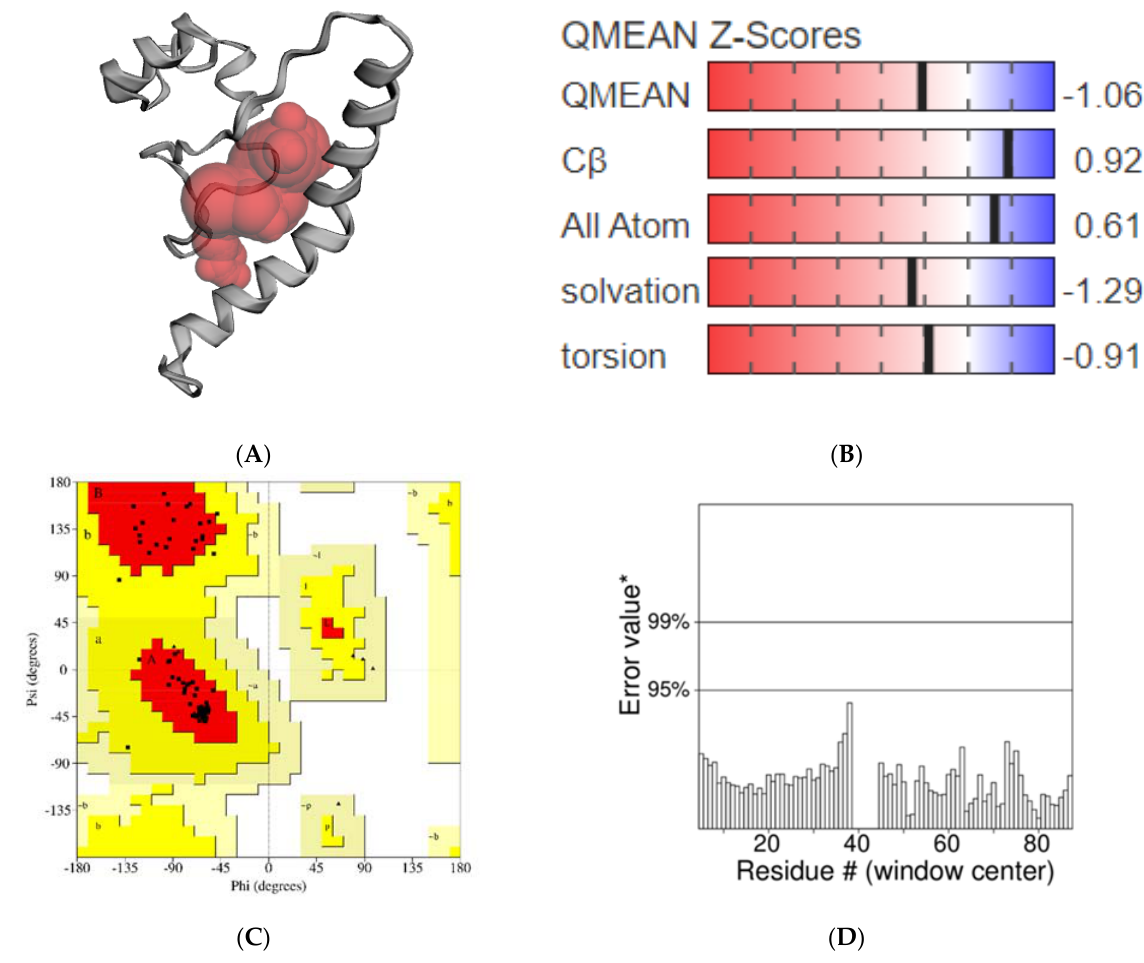
Figure 2. Validation of the predicted structure of AChE1. ( A ) Binding pocket predicted by CASTp; ( B ) QMEAN Z − Scrores value; ( C ) Ramachandran plot; ( D ) ERRAT plot. Note: Non ‐ glycine and non ‐ proline residues are shown as squares; Glycine residues are shown as triangles; [A, B, L]: Residues in most favoured regions; [a, b, l, p]: Residues in additional allowed regions; [~a, ~b, ~l, ~p]: Residues in generously allowed regions; Error value*:On the error axis, two lines are drawn to indicate the confidence with which it is possible to reject regions that exceed that error value; Residue #: Indate the residue number in protein model.